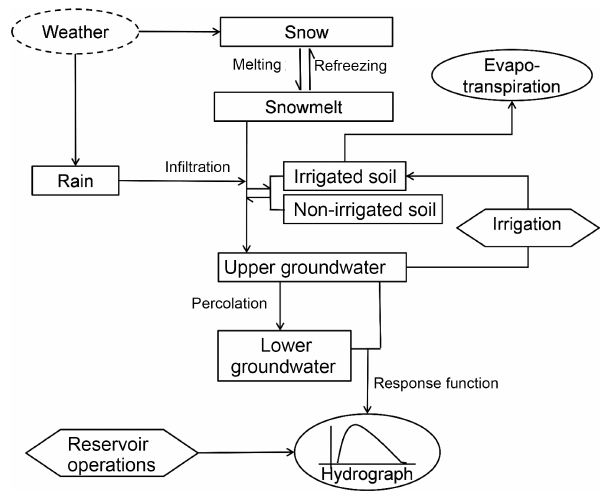
Figure 2. Flowchart of the Flow module in Envision. Note the hu- man activities influencing water availability. Water is distributed by the local water rights data (irrigation activities) and is also con- strained by the reservoir